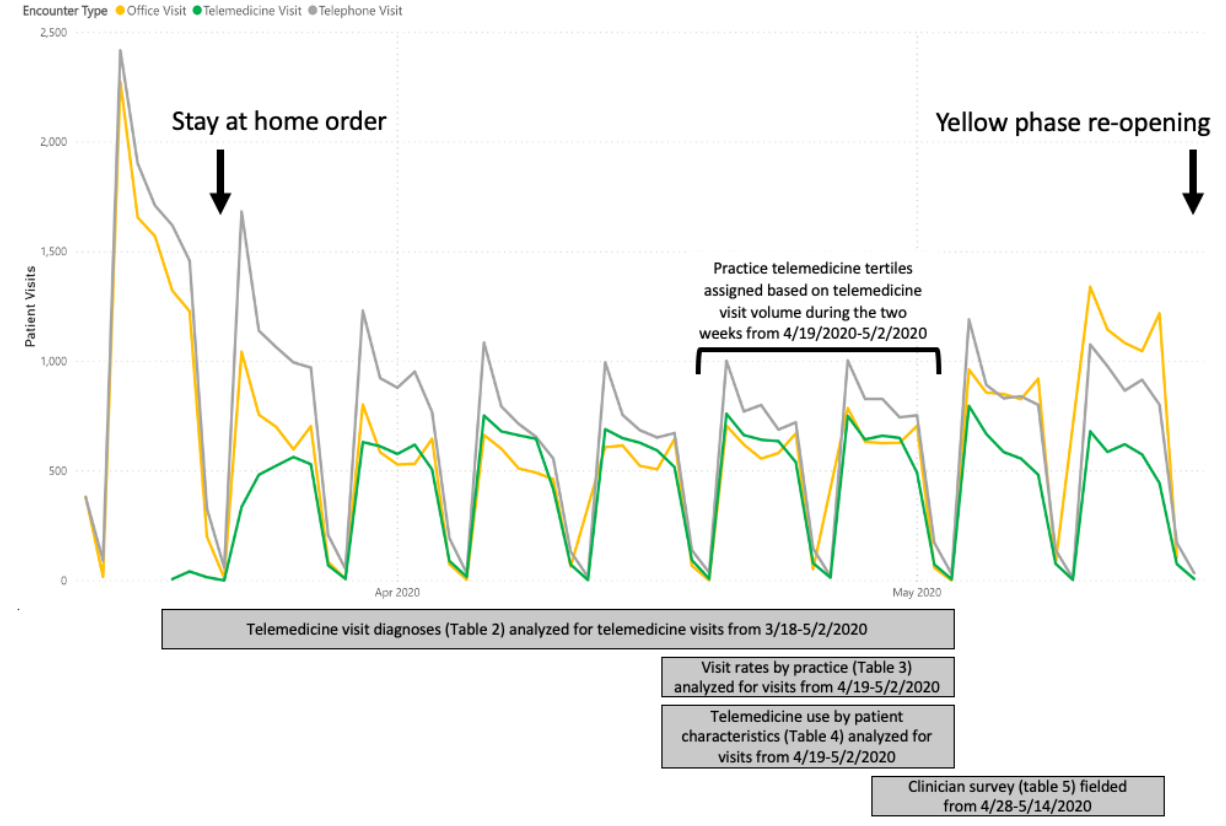
Figure 1. Encounters by telemedicine, in-person office, and care via telephone across 45 practices within a pediatric primary care network, March through May 2020. Telemedicine use tertiles were defined based on visit volume from April 19 to May 2, 2020 (indicated by brackets), as this period represented steady-state telemedicine use. Yellow phase indicates the first relaxation of the stay-at-home order, indicating the first phase of reopening in